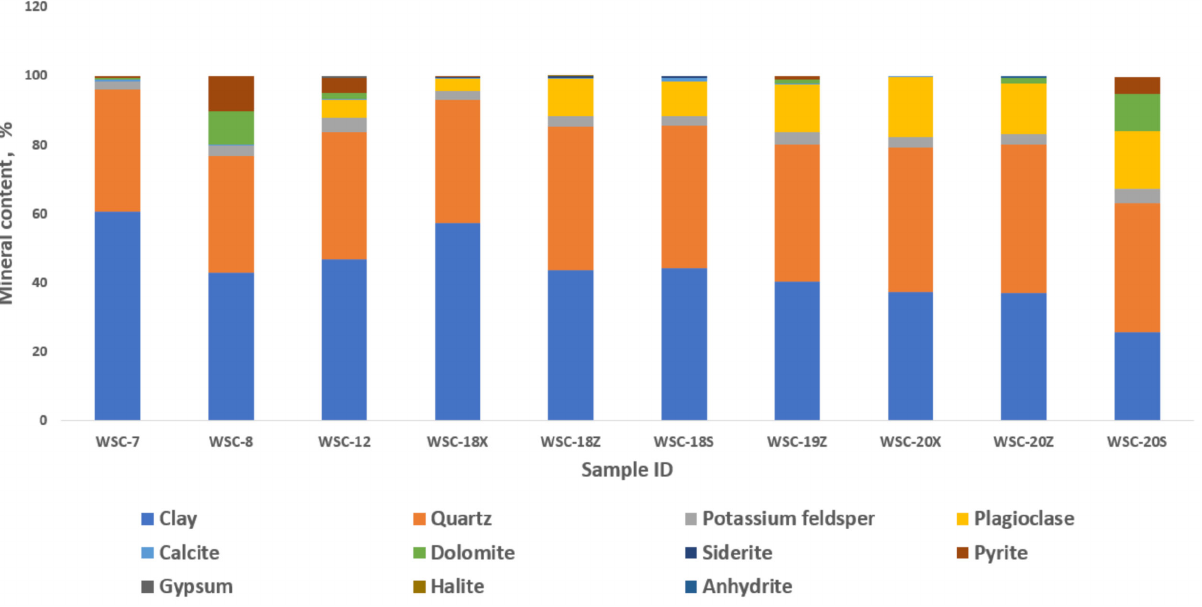
Figure 4. Mineral composition and content distribution of lower Cambrian shale from the Niutitang formation